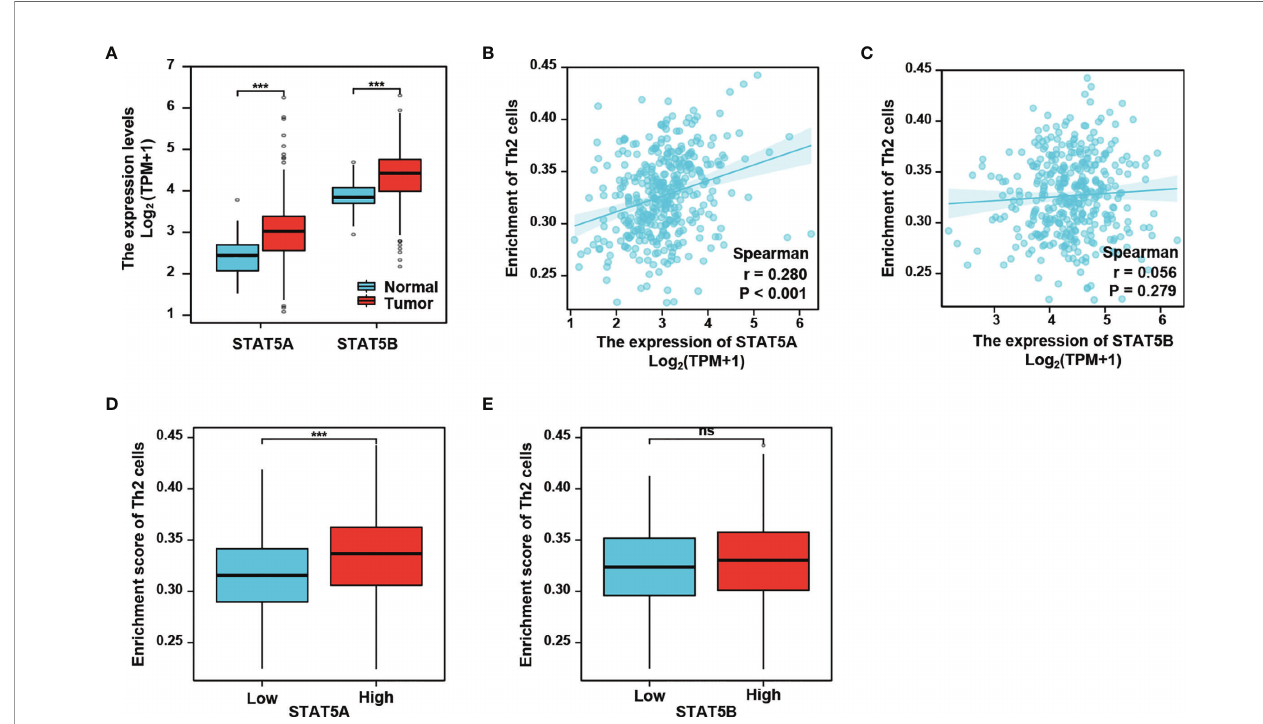
FIGURE 5 | STAT5A, but not STAT5B, is associated with Th2 cells in fi ltration. (A) STAT5A and STAT5B are signi fi cantly up-regulated in HCC compared with normal liver tissues. (B, C) Th2 cells in fi ltration in HCC is positively correlated with STAT5A, but not STAT5B. (D, E) Th2 cells in fi ltration is increased in STAT5A high group, but not in STAT5B high group. ***P<0.001, ns, not signi fi cant, for the indicated